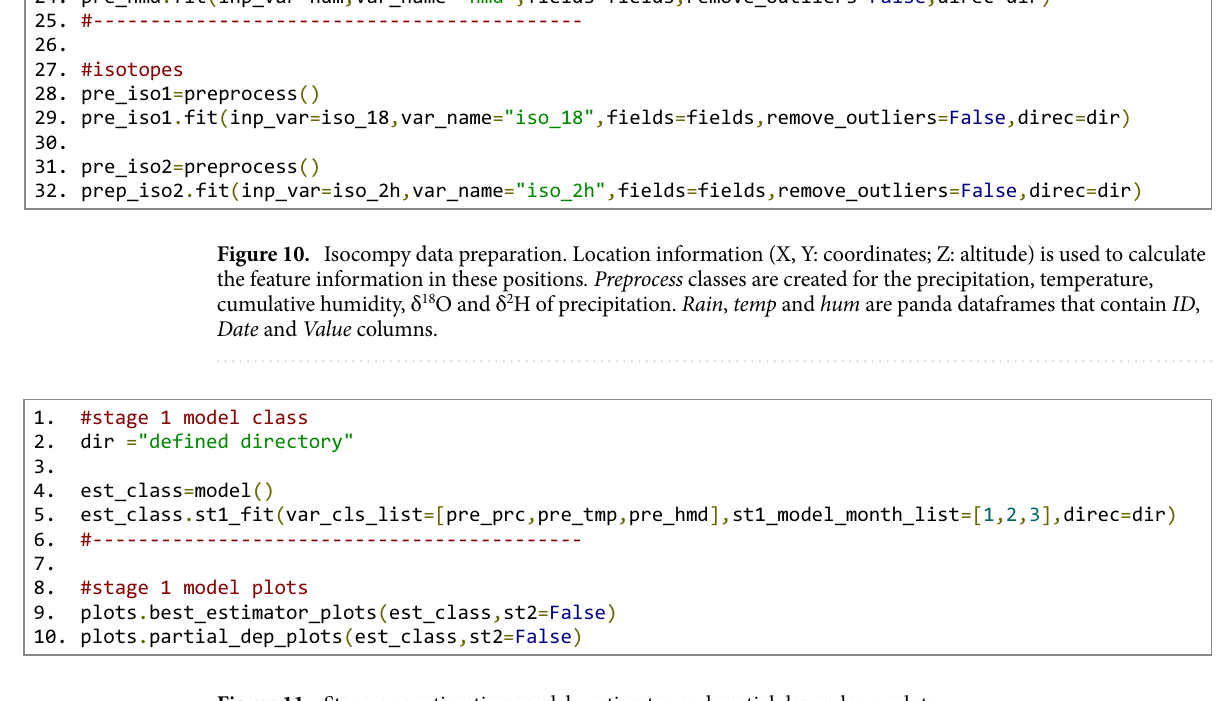
Figure 11. Stage-one estimation models, estimator and partial dependency